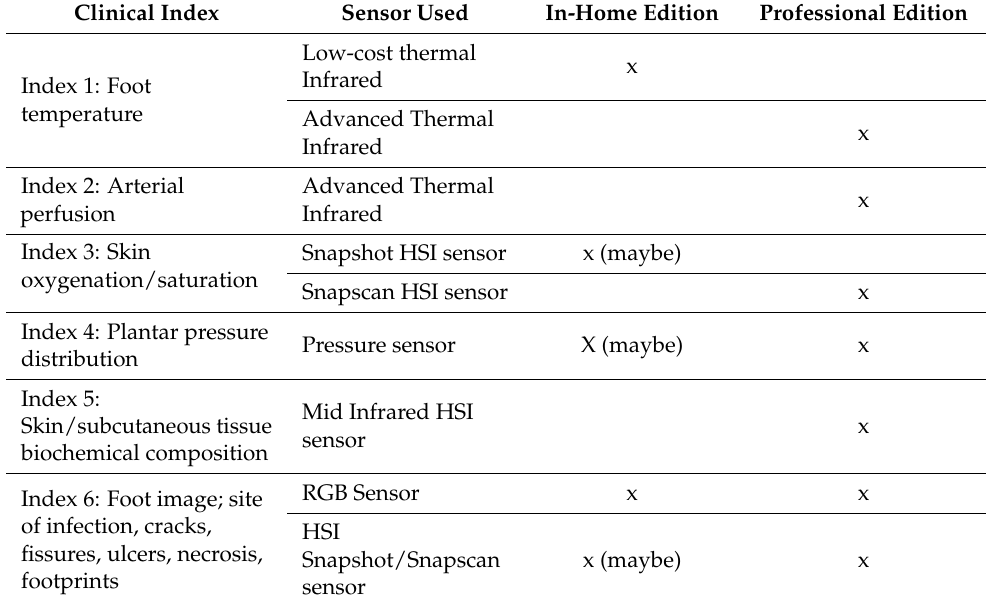
Table 1. Clinical indices needed to measure the status of a diabetic foot ulcer and relation of them to specific sensors used to quantify these measurements. We also indicate to which of the two editions of the device these indices are